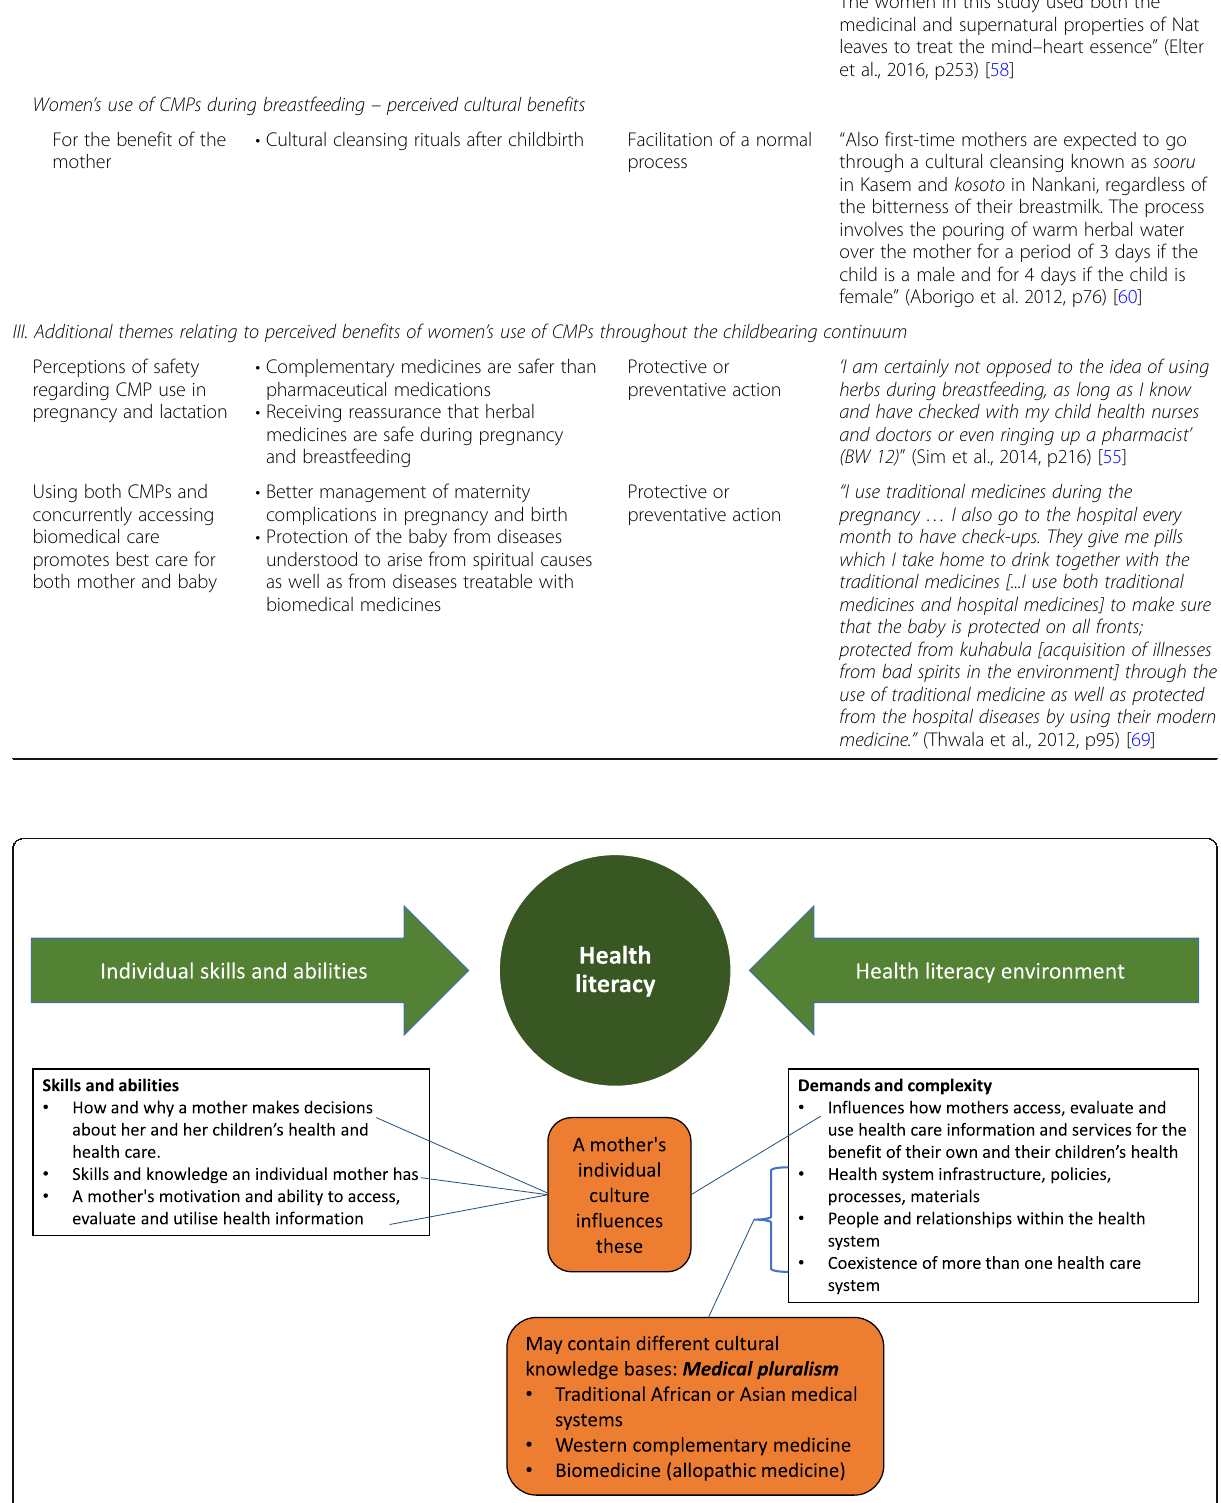
Fig. 4 Impact of culture on health literacy, modified from Parker [66] and the Australian Commission on Safety and Quality in Health Care ’ s working definition of health literacy [65]